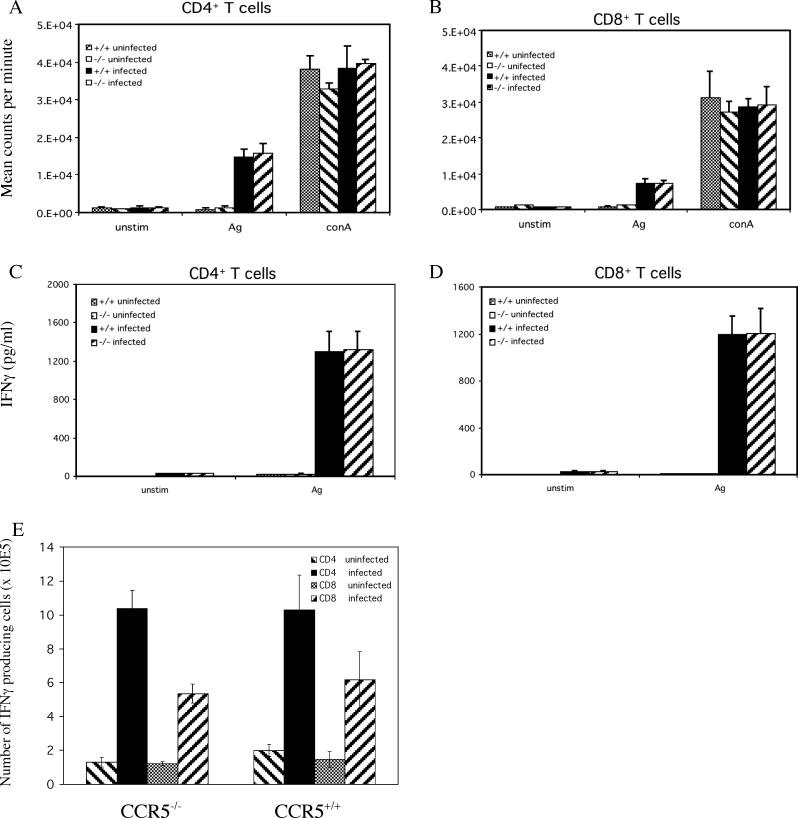
CD4+ and CD8+ T Cell T. gondii-Induced Proliferation and IFNγ Production(A and B) Proliferation. Magnetically purified positively selected CD4+ (A) and CD8+ (B) T cells (>95% pure) isolated from the spleens of C57BL/6x129 on day 7 PI. Cells were stimulated either with ConA (2.5 μg/ml) or Toxoplasma lysate antigen (15 μg/ml). After 72 h incubation, proliferation was measured by 3H thymidine incorporation. Data are represented as mean cpm ± standard deviation and are representative of two experiments.(C and D) IFNγ secretion. 106 purified CD4+ (C) and CD8+ (D) T cells from 7 d infected C57BL/6x129 mice were cultured in presence of 15 μg/ml of Toxoplasma lysate antigen and irradiated feeder cells (5 × 105 cells/well) in 24-well plates. After 72 h of incubation the supernatants were collected, centrifuged, and assayed for IFNγ production by ELISA.(E) Intracellular IFNγ production. Female CCR5−/− (5–8 wk old) and wild-type mice were infected perorally with T. gondii cysts and splenocytes were harvested at day 7 PI, pooled (three mice per group), and cultured in vitro with phorbol 12-myristate 13-acetate, ionomycin, and monensin for 4 h. The cultured cells were stained for CD4 or CD8 before intracellular staining for IFNγ. Data are presented as percentage (mean ± standard deviation) of CD4+ or CD8+ T cells positive for IFNγ and are pooled from two experiments.